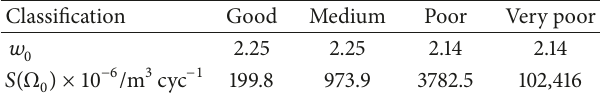
Table 1: The parameters of the unpaved off-road